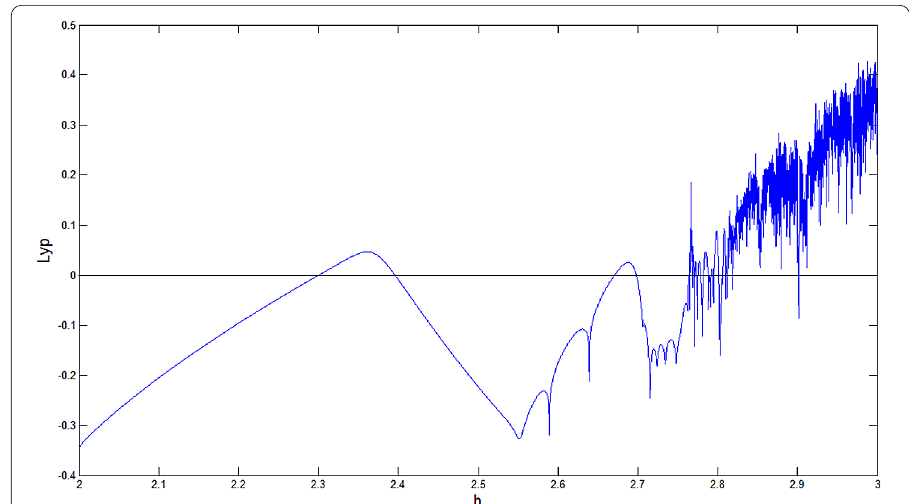
Figure 3 Maximal Lyapunov exponents corresponding to Figure 1